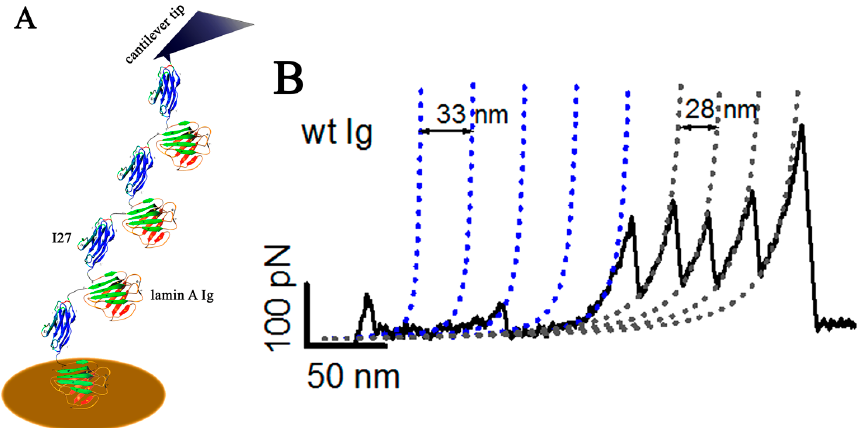
Figure 1. Schematic diagram of stretching of the Ig-fold domain in single molecule force spectroscopy (SMFS) and the force-extension curve. ( A ) Illustration showing the construct of alternating units of Ig and I27, which are pulled by a cantilever tip from the gold coated cover slip containing a drop of the protein. ( B ) Force extension curves plotting the unfolding force and change in contour length. The curve is fitted with a worm-like chain model of polymer elasticity. (Reproduced with permission from Bera et. al, Biochemistry, 2014).